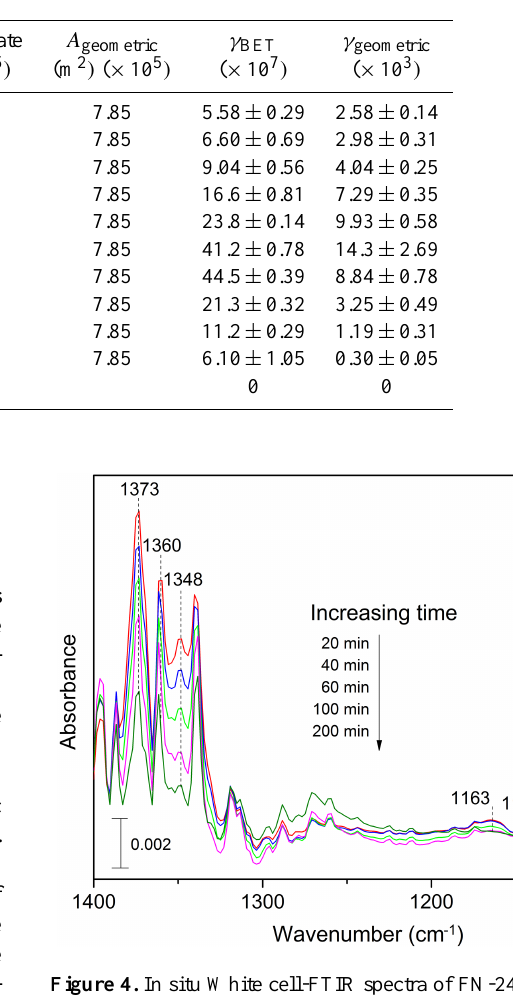
Table 2. Sulfate formation rates and uptake coefficients for heterogeneous reactions of SO 2 on hematite and the hematite–nitrate mixtures at 298K.